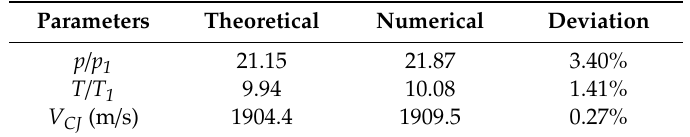
Table 1. Comparisons of theoretical and numerical detonation wave parameters.